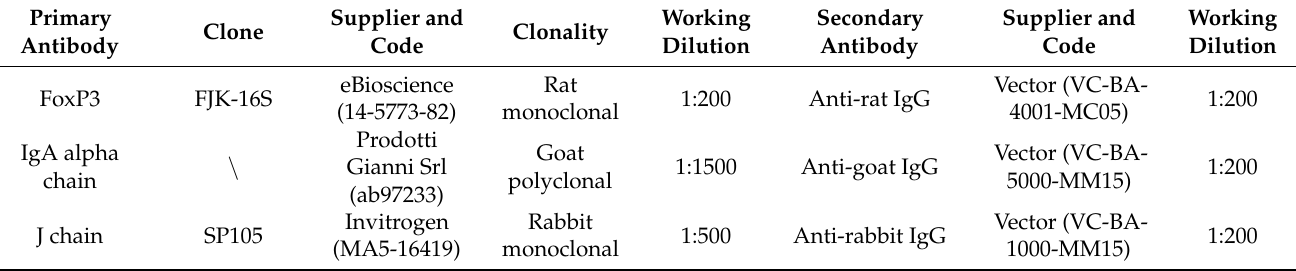
Table 7. List of primary antibodies used in the immunoistochemisty